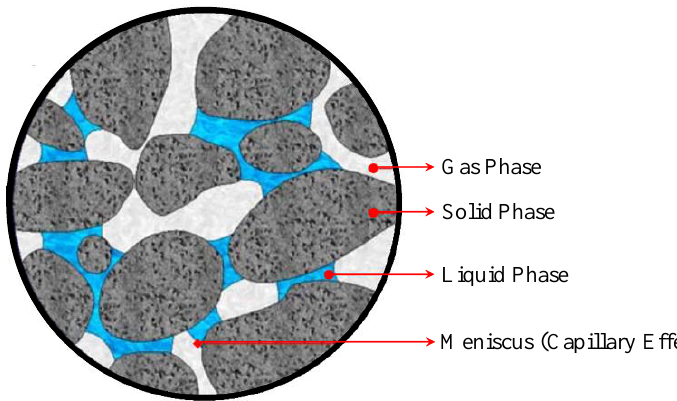
Figure 2. Representative averaging volume of a three-phase system (see also Bear and Bachmat [29]; Lewis and Schrefler [17]).